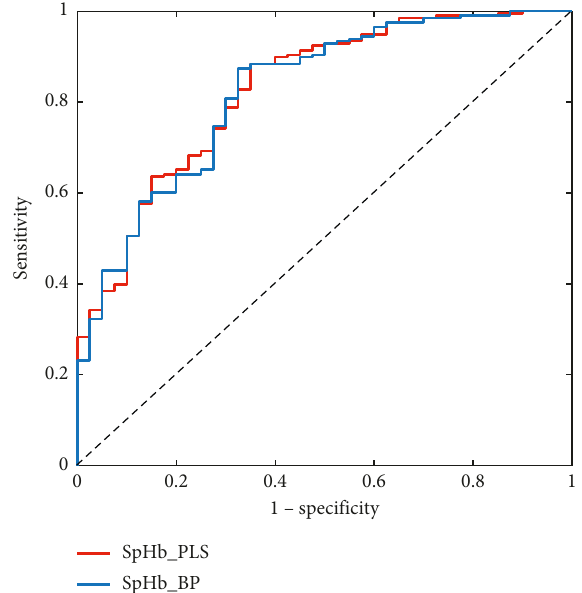
Figure 6: ROC to predict gold standard invasive Hb of greater than 12g/dL for PLS and BP-ANN